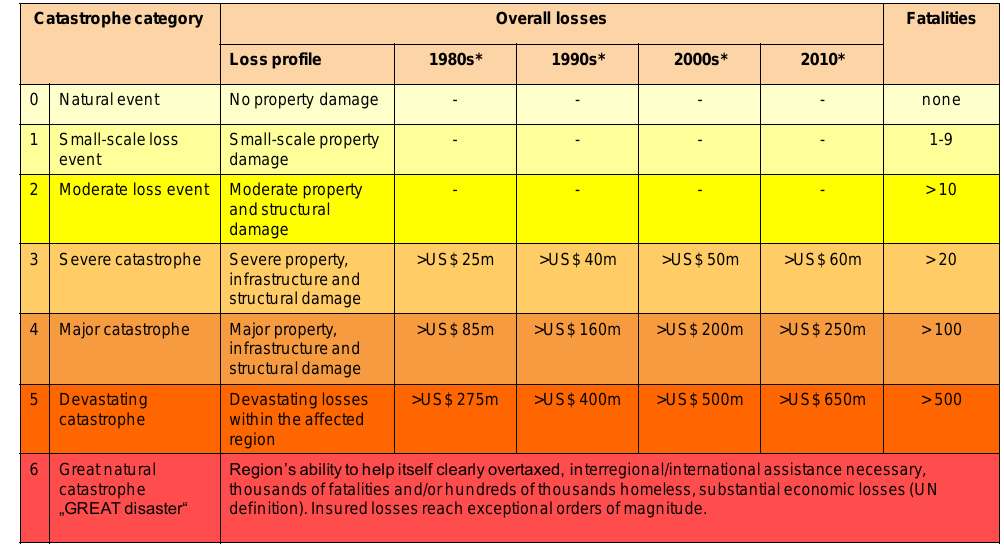
Fig. 1. Catastrophe categories in NatCatSERVICE; at least one of the two criteria, overall losses and fatalities, must be met to qualify for a higher category. ∗ Losses adjusted to the decade average, in 2010